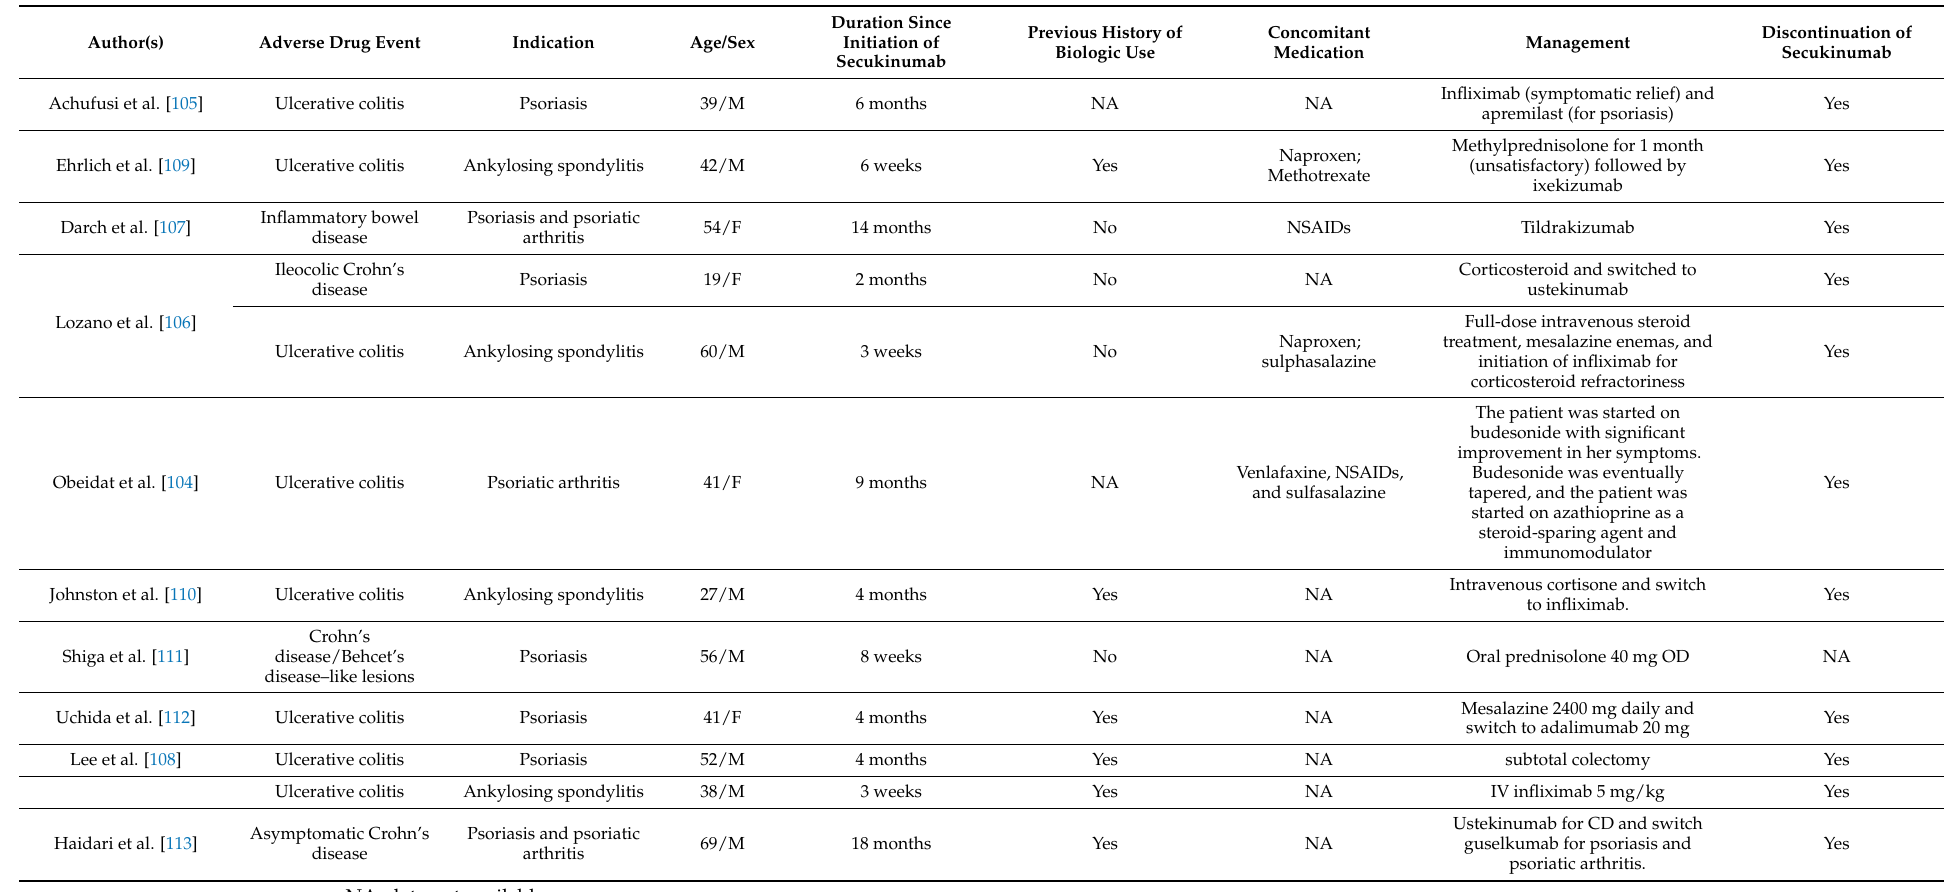
Table 4. Case reports of inflammatory bowel disease associated with secukinumab